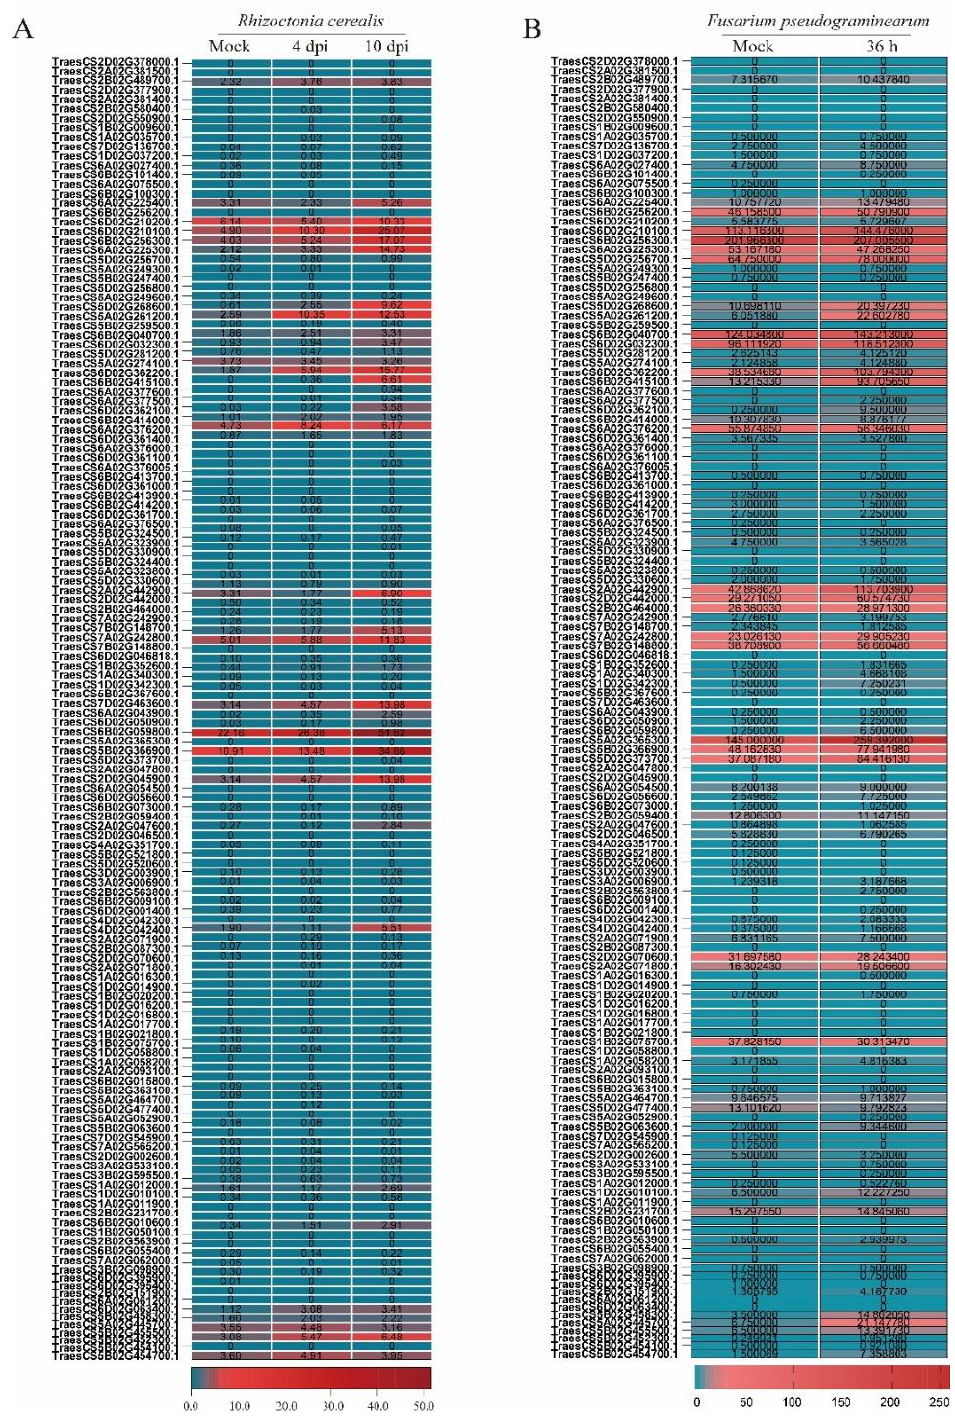
Figure 2. The transcript profiles of 140 TaWAKs in the wheat RNA-sequencing (RNA-seq) data. ( A ) The transcript levels of 140 TaWAKs upon R. cerealis infection in the resistant recombinant inbred lines (RILs) derived from the cross ‘Shanhongmai’ × ‘Wenmai 6′ . ( B ) The transcript profiles of 140 TaWAKs upon F. pseudograminearum infection. The RNA-seq data upon F. pseudograminearum infection were checked from the online RNA-seq data (http://www.wheat-expression.com/ accessed on 25 August 2022) [32].